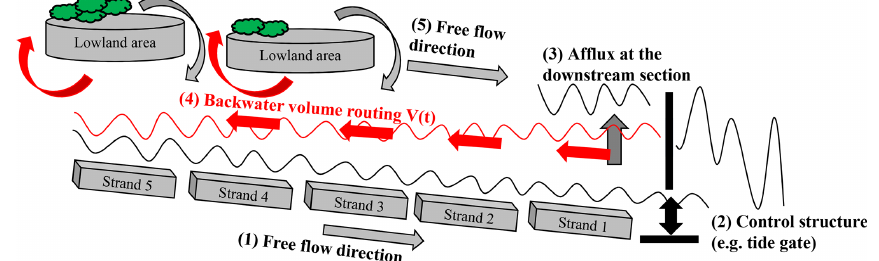
Figure 2. Scheme of five computation steps in the developed concept to compute backwater effects with a hydrological approach: (1) free- flood-routing computation downstream, (2) control structure simulation, (3) afflux computation, (4) backwater-volume-routing computation in the upstream direction including adjacent lowland areas (as well as retention areas) and (5) free-flood-routing computation after opening the barrier.